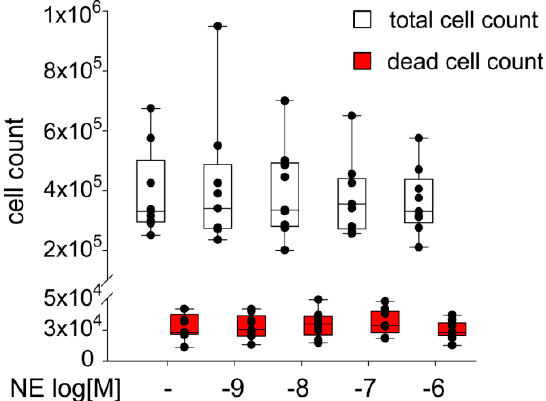
Figure 4. Proliferation capacity of sASCs in presence of NE in di ff erent concentrations (10 − 9 –10 − 6 M). The white boxes represent the total number of cells, the red boxes represent the number of dead cells after seven days. Data are presented as box plots, where the boxes represent the 25th to 75th percentiles, the lines within the boxes represent the median, and the lines outside the boxes represent the 10th and 90th percentiles (untreated control = 100%, broken line). Each black circle represents an individual patient ( n =